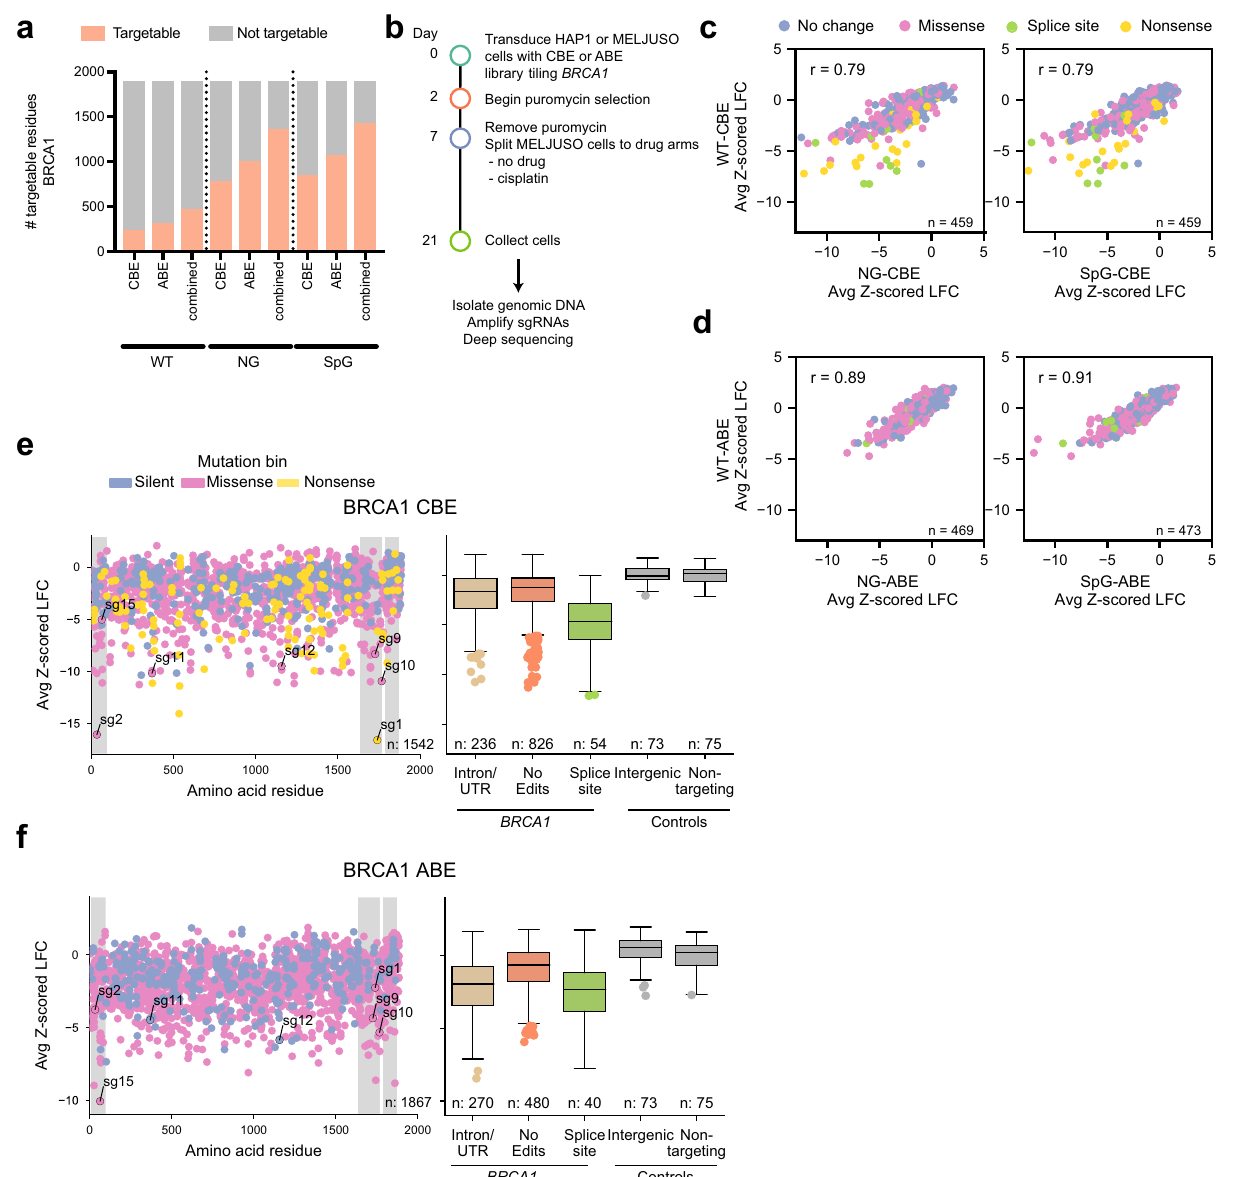
Fig. 5 Tiling BRCA1 with variant base editors. a Number of targetable residues in BRCA1 using the base editors paired with the library described in this study. b Timeline by which tiling screens were conducted. c Comparison of NG and SpG-CBEs to WT-CBE with shared guides predicted to introduce no change (silent or no edits), splice site, nonsense, or missense mutations with an NGGN PAM. Pearson ’ s r is reported for each comparison. d Same as ( c ) but for ABEs. e , f Average performance of sgRNAs (averaged Cas9-NG and SpG screens) targeting BRCA1 , colored according to the predicted mutation bin, for CBE and ABE screens. The fi rst grey shaded region spans the RING domain, and the following two indicate the BRCT repeats. Boxes show the quartiles (Q1 and Q3) as minima and maxima and the center represents the mean; whiskers show 1.5 times the interquartile range (Q1-1.5*IQR and Q3 + 1.5*IQR). Source data are provided as a Source Data fi le. primary screening results, as sgRNAs might deplete due to out- of-window editing, unintended edits, indels, or off-target